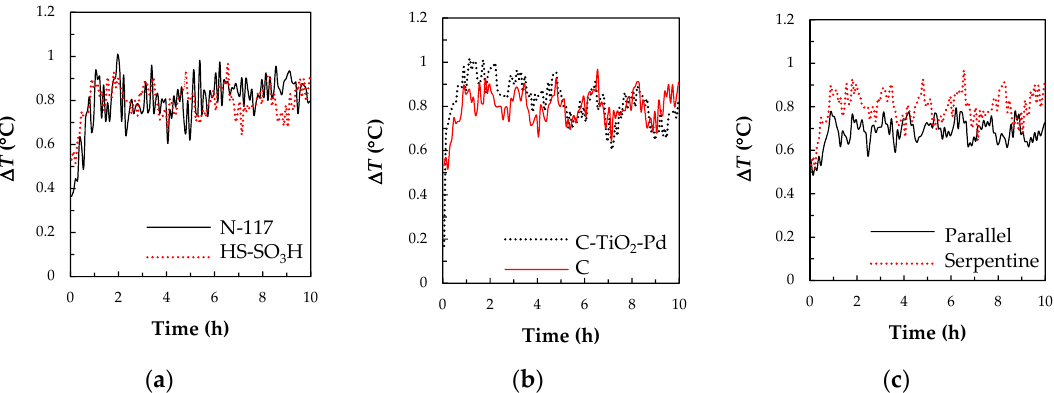
Figure 11. Show the temperature change ( ∆ T ) vs. the charge / discharge cycle time for V / I RFB with different key materials: ( a ) separation membranes, ( b ) electrodes and ( c ) flow fields. The charge-discharge conditions: the 1.0 M VOSO 4 / 2.0 M H 2 SO 4 was as the positive electrolyte, iodine / ascorbic acid solutions as the negative electrolyte at a flow rate of 60 mL / min and a current density of 40 mA / cm 2 . Table 6. The performance of charge-discharge test for the V / I RFB with various key